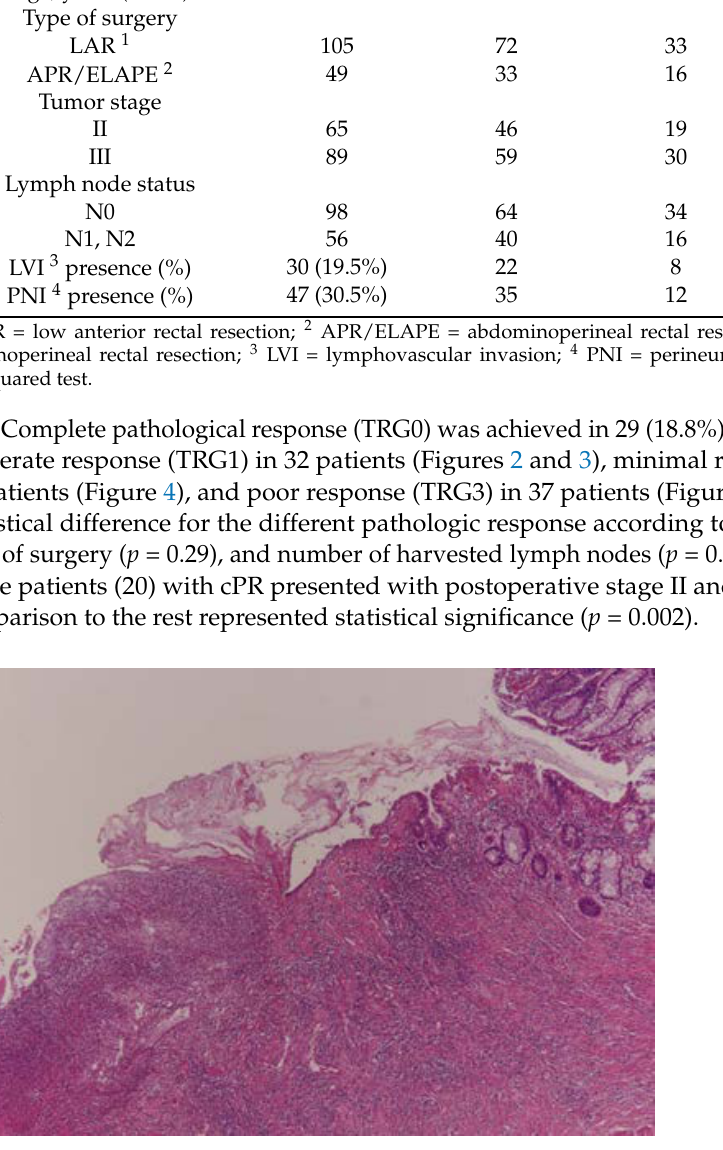
Figure 2. Moderate pathological response (TRG1); x 40 HE; Mucosal ulcer, glandular tumor in mus- cularis propria. Figure 3. Moderate pathological response (TRG1); x 40 HE; Calcifications in the muscularis pro- pria.